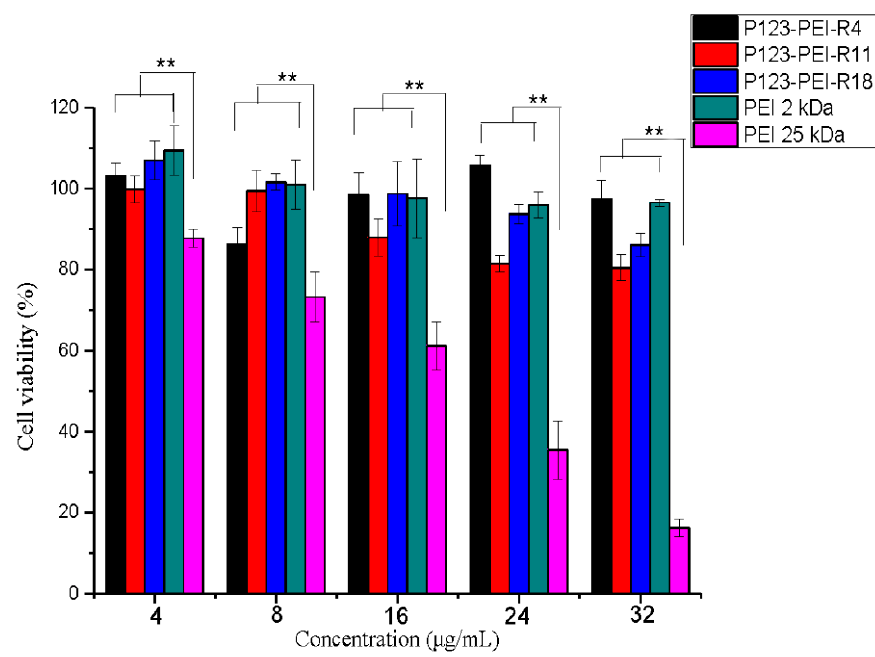
Figure 6. Cytotoxicity of PEI 25 kDa, P123-PEI, P123-PEI-R4, P123-PEI-R11 and P123-PEI-R18 at various concentrations in B16 cell lines using the MTT assay. ** p < 0.01.